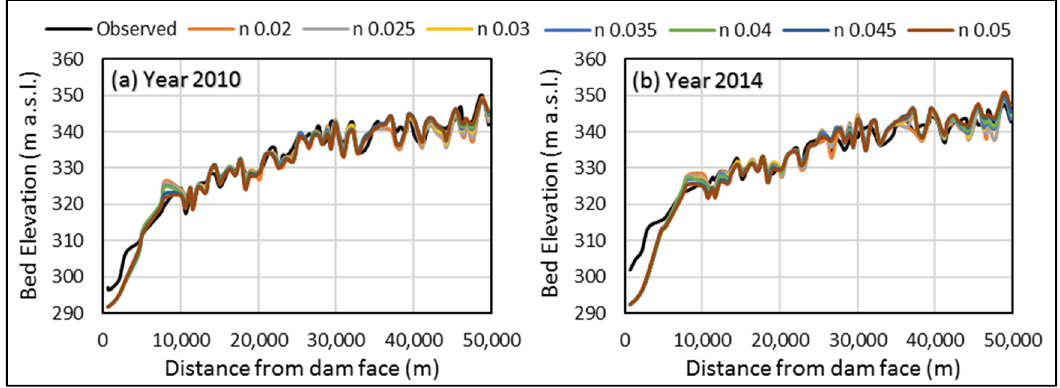
Figure 9. Comparison of the observed and simulated bed elevation for different Manning’s roughness coefficients. Table 2. Statistical analysis for sensitivity analysis for calibration and